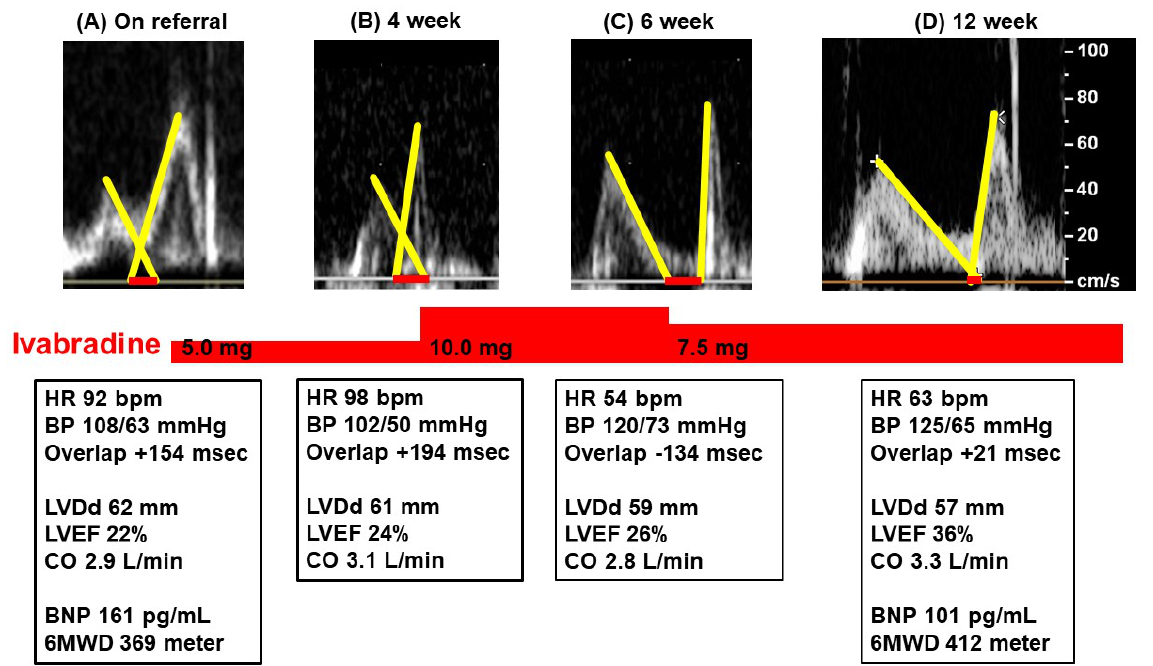
Figure 2. Trends in Doppler echocardiography trans-mitral inflow waves and clinical data on referral ( A ), 4 weeks later ( B ), 6 weeks later ( C ), and 12 weeks later ( D ). Ivabradine was initiated on referral and the dose of ivabradine was titrated to minimize the overlap length (red bars). HR, heart rate; BP, blood pressure; LVDd, left ventricular end-diastolic diameter; LVEF, left ventricular ejection fraction; CO, cardiac output; BNP, B-type natriuretic peptide; 6MWD, 6-min walk distance.